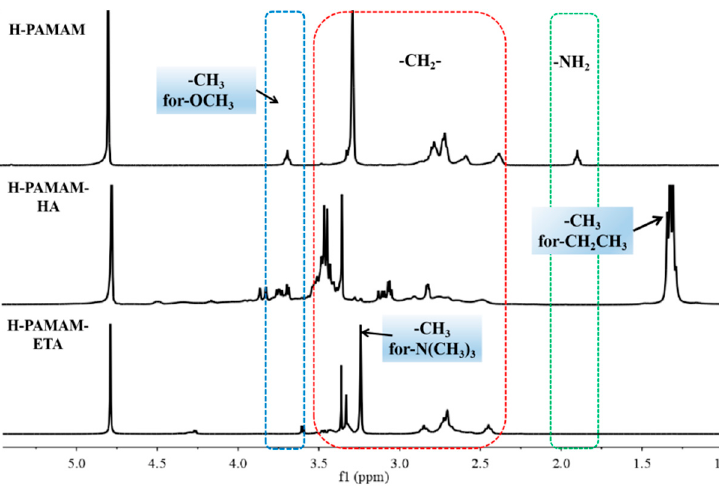
Figure 1. The 1 H NMR spectra of the demulsifiers.